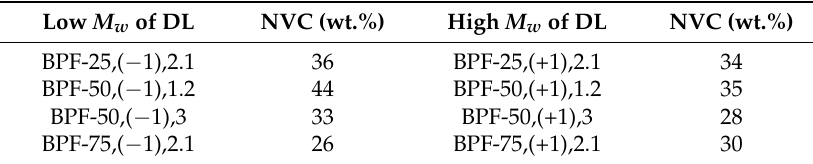
Table 6. NVC of BPF resoles with increasing M w of DL (left to right). Low M w of DL NVC (wt.%) High M w of DL NVC (wt.%)